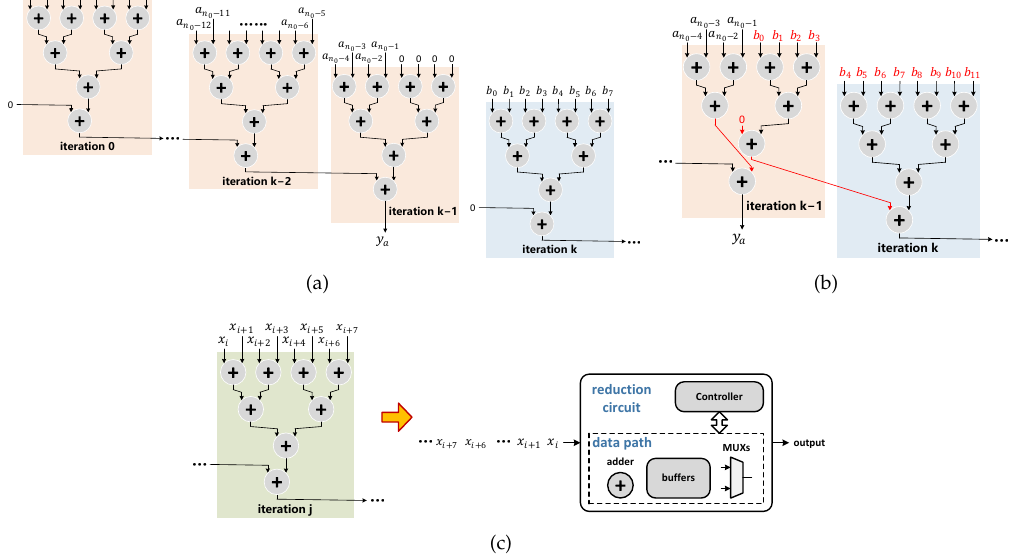
Figure 3. The design idea of BTPP. ( a ) structured calculation pattern combining binary tree and adder chain; ( b ) apply path partition to improve system performance; ( c ) BTPP hardware design: use only one reduction